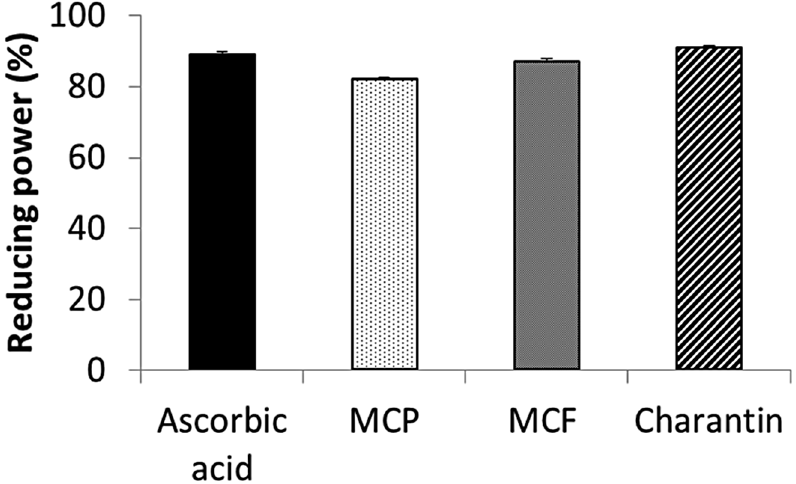
Fig 5. The reducing power of 15 mg/ml extracts of MCP, MCF and charantin. Reducing power of MCP, MCF and charantin (15 mg/ml) extracts were determined over a period of 30 minutes at 50°C using the potassium ferricyanide method. Ascorbic acid was used as a positive control. The results are presented as mean ± SD (n = 3). There was no significant difference between the extracts and ascorbic acid.